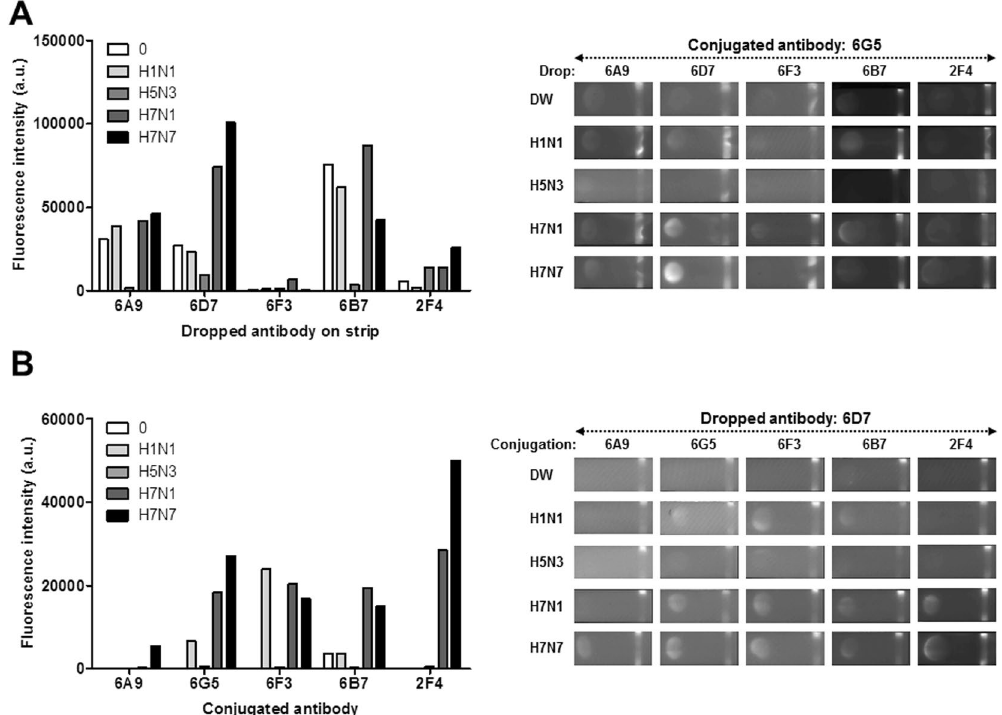
Figure 2. Monoclonal antibody (mAb) reactivities with different H7 virus strains and subtypes in the dot-FICT assay. Dot-FICT assays were used to examine the specificity of the mAbs against different AI virus subtypes and diverse H7 isolates. 6G5 was chosen as detection element and was conjugated with Europium. Five clones were used for dotting on strip and different virus subtypes were applied to the dot-FICT assay ( A ). 6D7 was chosen for dotting on strip and other antibodies were conjugated with Europium and dot-FICT assay was performed ( B ). Raw data for fluorescent image of dotting are shown in the right panel of each Optimization of FICT assay. Figure 4A schematically illustrates the Europium conjugate-based FICT assay. The test strip for FICT has a conjugate pad for conjugate and a sample pad for application of sample on a nitro- cellulose membrane. Anti-influenza H7 subtype-specific antibody (6D7) and anti-mouse IgG Abs were coated on the test line (TL) and the control line (CL) of the nitrocellulose membrane, respectively. To perform the diagnos- tic assay, the conjugates were loaded on the conjugation pad in advance. Virus in lysis buffer was applied to the sample pad. In the absence of virus, the conjugates failed to react with mAb in the TL. However, in the presence of virus, conjugate was on TL line. At the CL, anti-mouse IgG recognized the antibody on conjugate. After the application of sample to the strip, the fluorescence intensity was digitalized by the light-emitting diode-based portable strip reader in 15 min. The optimal performance of the FICT assay was obtained using 1,000 HAU/mL of H1N virus and H7N7 virus. The dot-FICT did not showed cross-reactivity with the Abs when H1N1 was present at 1,000 HAU/mL (Fig. 4B). Nonspecific reaction of bioconjugate was explored by using different amounts of bovine serum albumin (BSA, 0.3125–5%) in conjugate storage buffer. BSA at 5% was able to decrease the cross-reaction of H1N. This concen- tration was chosen for the bioconjugate, even though H1N1 cross-reactivity persisted. Instead of the increasing BSA further, we tested different pHs (8–12) of lysis buffer. The cross-reaction of H1N1 was decreased with reactivity of H7N7 virus (Fig. 4C). The remaining cross-reaction of H1N1 was not significantly different at pH 12 but the reactivity of H7N1 was decreased at that pH. Therefore, we chose the lysis buffer of pH 11. The results indicate that lysis buffer plays a key role in the antigen-Ab environment in addition to helping the migration of samples on a nitrocellulose membrane without non-specific reaction. FICT assay performance. viously 25 . The FICT displayed H7N9 HA1 reactivity with good correlation (r 2 = 0.9826), but no reactivity with H5N1 rHA1 (Fig. 5). LOD for H7N9 rHA1 was 31 ng/mL. The proposed diagnostic system targeted the HA1 H7 subtype. To confirm the virus specificity, serial dilutions (20–640 HAU/mL) of the H1N1, H5N3, H7N1, and H7N7 subtypes were tested in FICT using a 2F4 (conjugate)/6D7 (strip) Ab pair. The proposed assay showed good linear regression for H7N1 virus (r 2 = 0.9743) and H7N7 virus (r 2 = 0.9897). However, it could not recognize the other two subtypes tested (Fig. 6A). LOD was 40 HAU/mL of two H7 subtypes. Therefore, the assay had H7 subtype specificity.